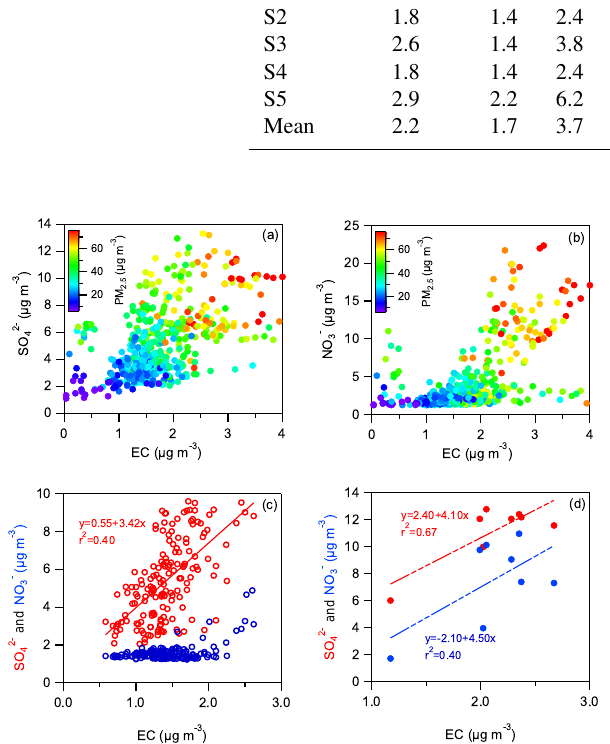
Figure 10. Hourly sulfate (a) and nitrate (b) plotted against EC, with the dots colored according to PM 2 . 5 mass concentrations.